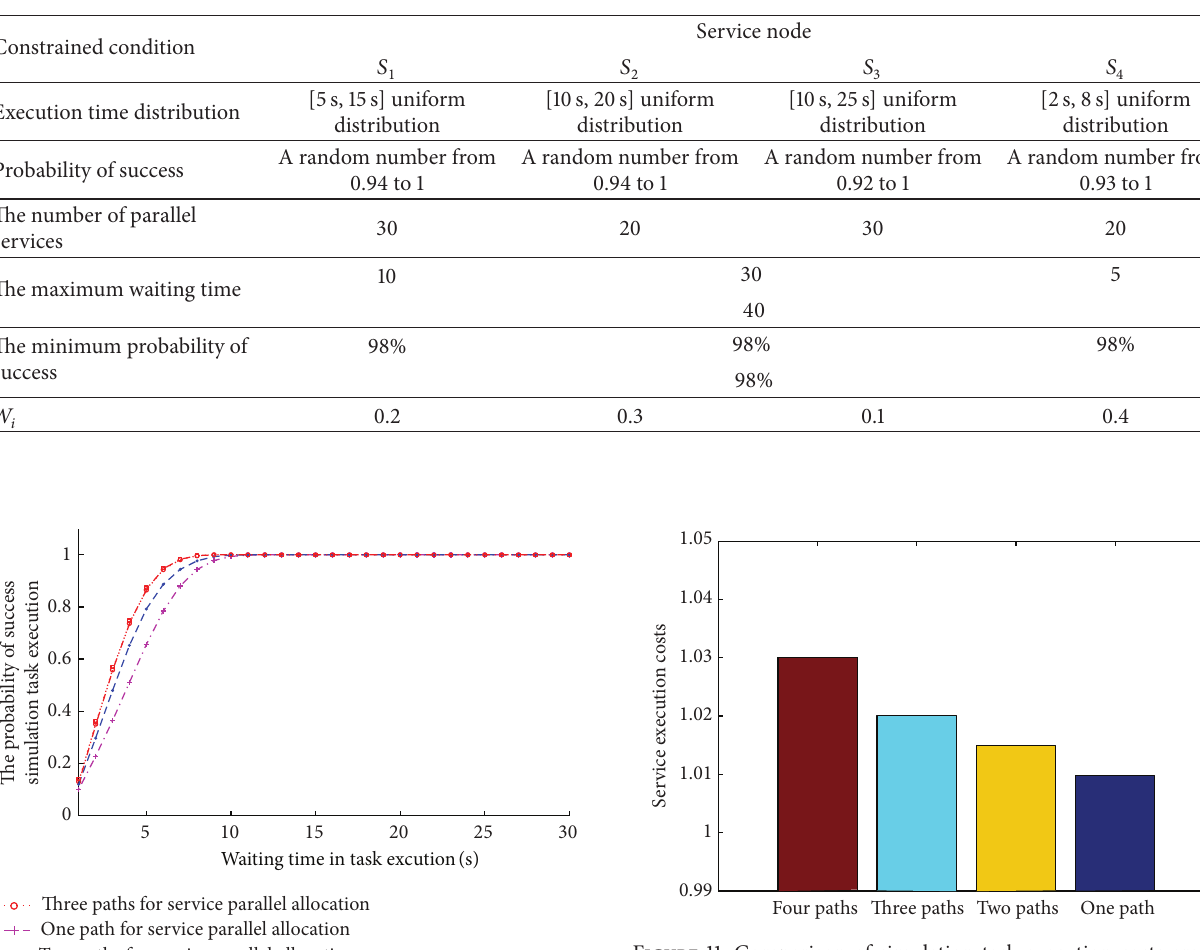
Figure 11: Comparison of simulation task execution costs among different